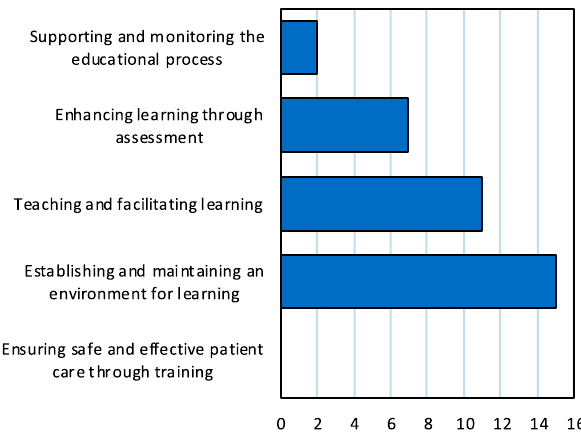
Figure 1: Frequency of developmental actions per speci fi c area of exper- tise for the clinical